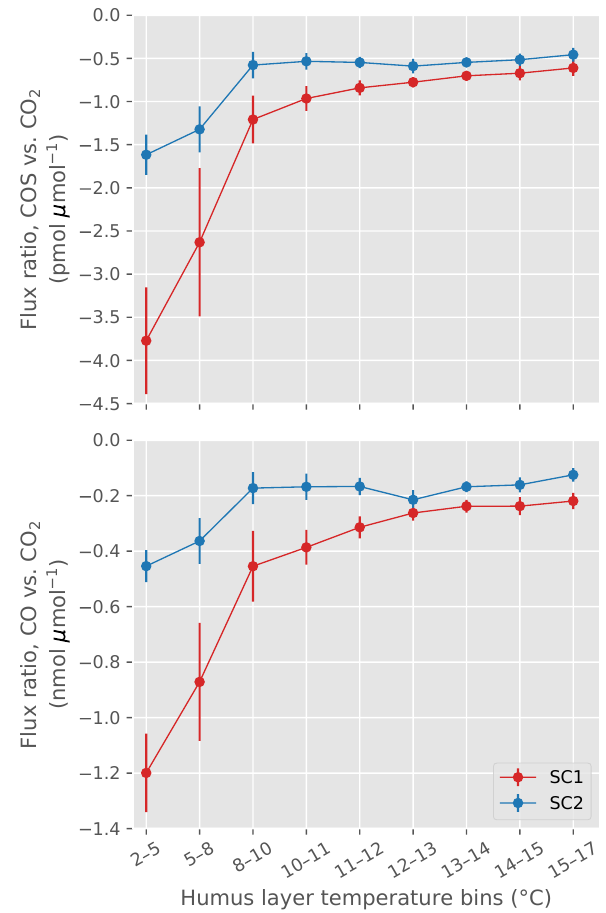
Figure 6. Ratios of COS vs. CO 2 and CO vs. CO 2 fluxes deter- mined from zero-intercept linear regressions across soil temperature bins. Error bars are showing ± 2 standard errors (or 95.5% confi- dence interval). Flux ratios are generally smaller in SC2 because of higher CO 2